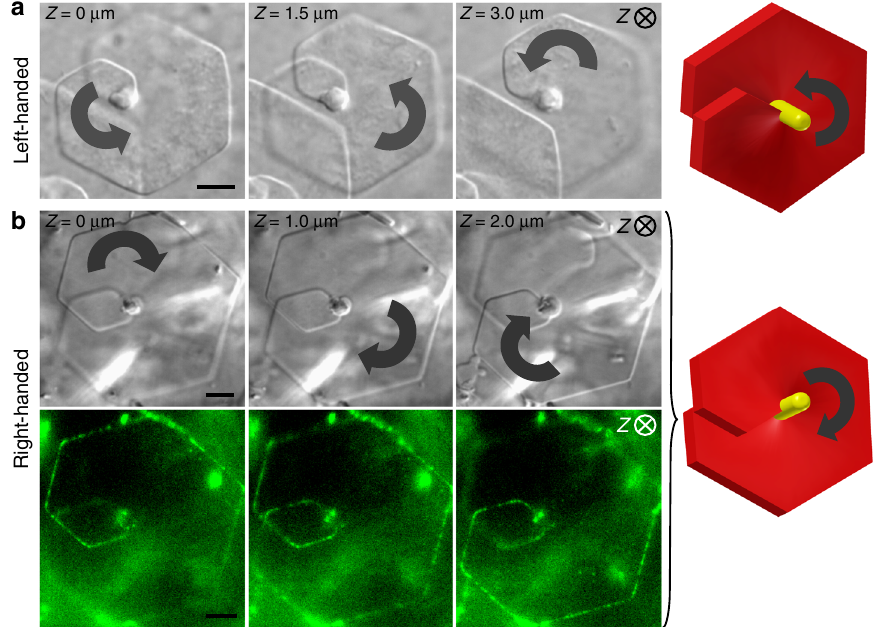
Fig. 2 Hexagonal platelets with opposite screw dislocation handedness as shown by optical microscopy by capturing images at different focal depths Z (along the platelet main axis, n ) and corresponding schematic representations. a Left-handed screw dislocation (DIC, Supplementary Movie 3). The handedness is indicated by a black curved arrow. b Right-handed screw dislocation (upper: DIC, Supplementary Movie 4; lower: fl uorescence, Supplementary Movie 5) for which the hexagonal platelet edge is decorated with fl uorescently labeled rods. Scale bars, 2 μ